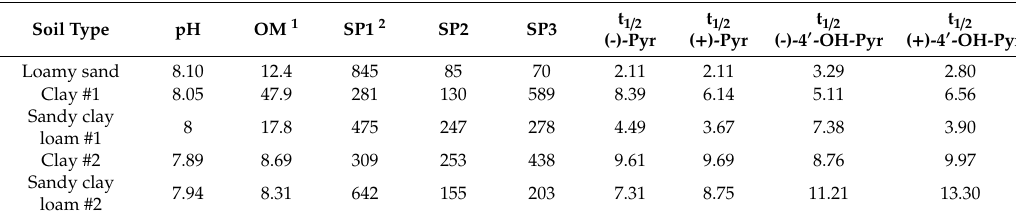
Table 2. Half-life values (t 1 / 2 in days) of pyriproxyfen enantiomers and those of its main metabolite in five types of soils under aerobic conditions (adapted from